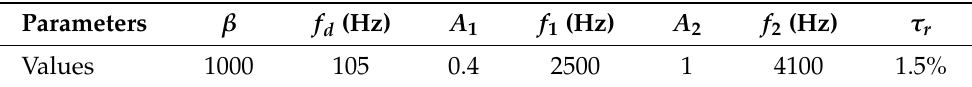
Table 1. Simulated bearing fault